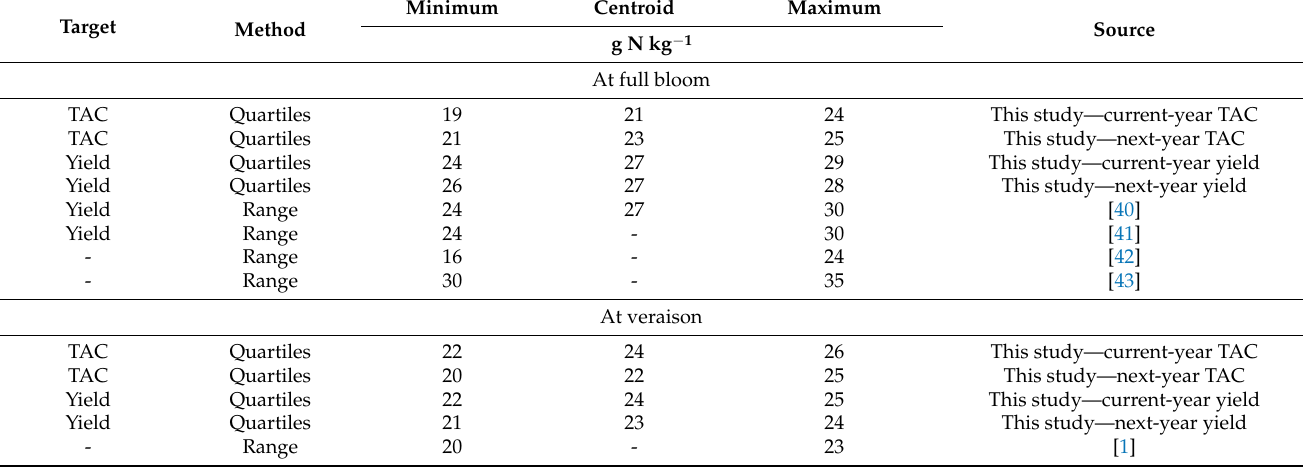
Table 3. The foliar N ranges at full bloom and veraison using the yield and TAC as the target variables and comparison with the ranges reported in the